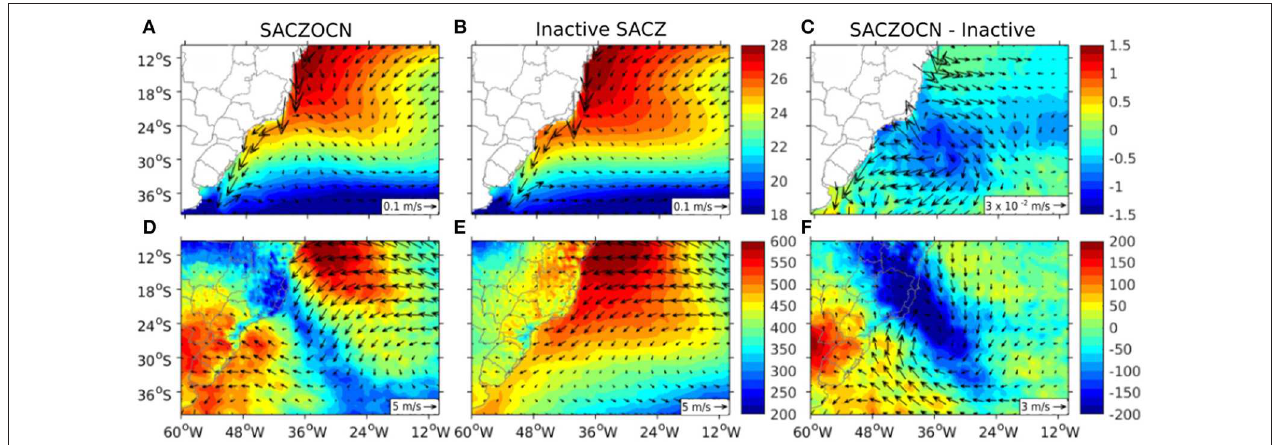
FIGURE 9 | (A,B) SST ( ◦ C) and superficial oceanic currents (m s − 1 ). (D,E) daily time downward shortwave radiation (W m − 2 ) and 10 m wind. (A,D) are the composites for the SACZOCN episodes and (B,E) are the composites for inactive SACZ days. (C,F) are the difference between SACZOCN and inactive SACZ.